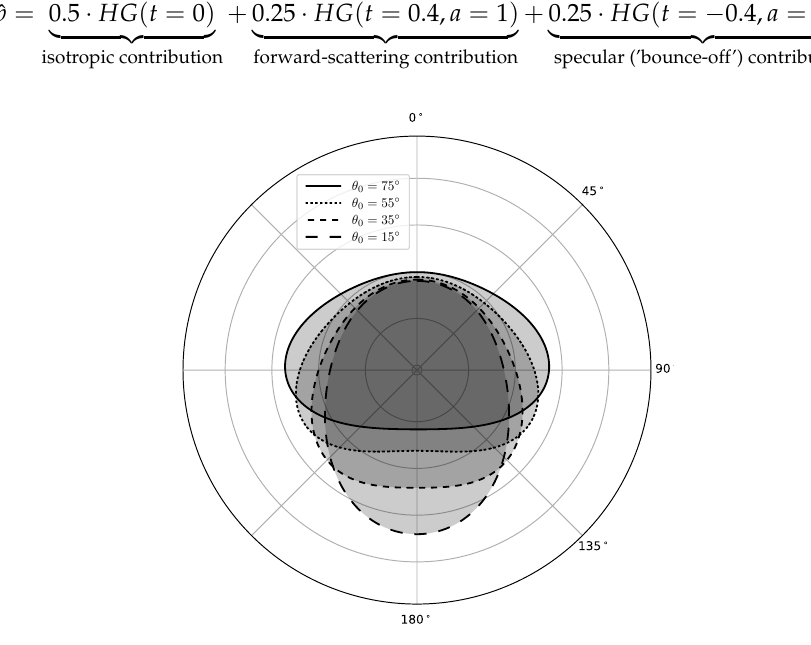
Figure 8. Polar-plot of the resulting shape of ˆ p